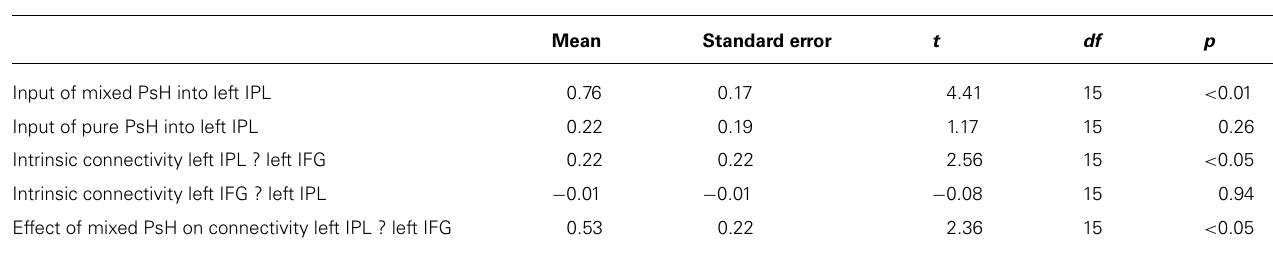
Mean Standard error